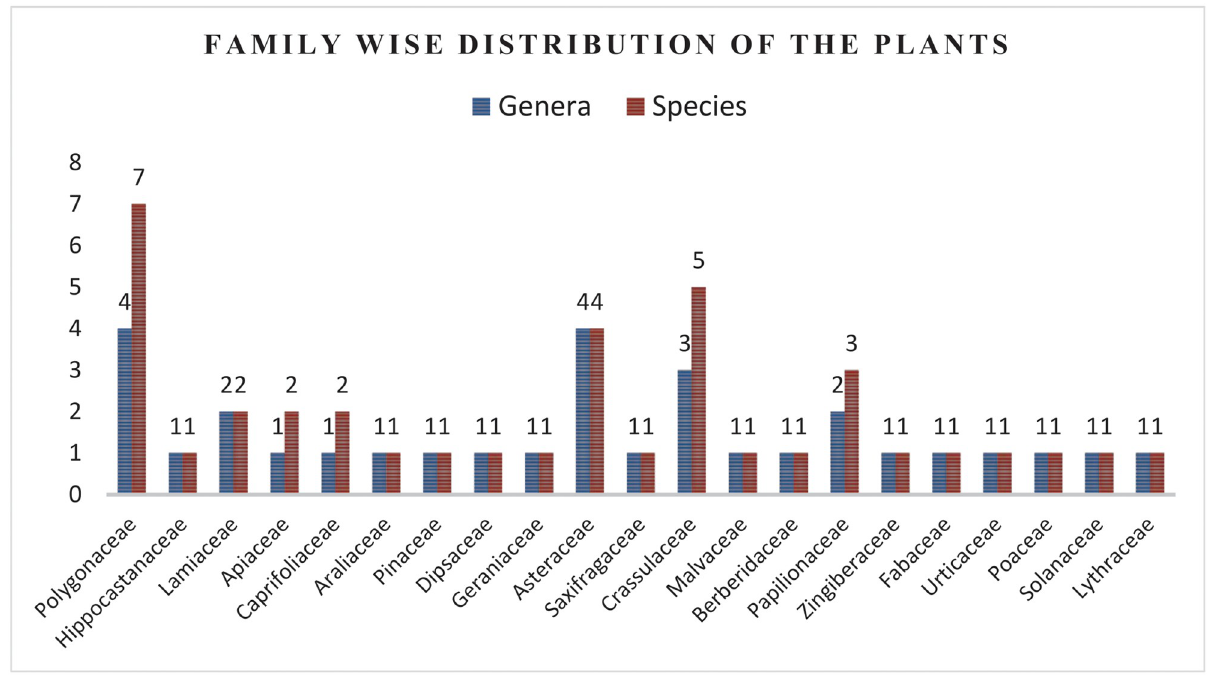
Fig 2. Family-wise distribution of the plants used for veterinary